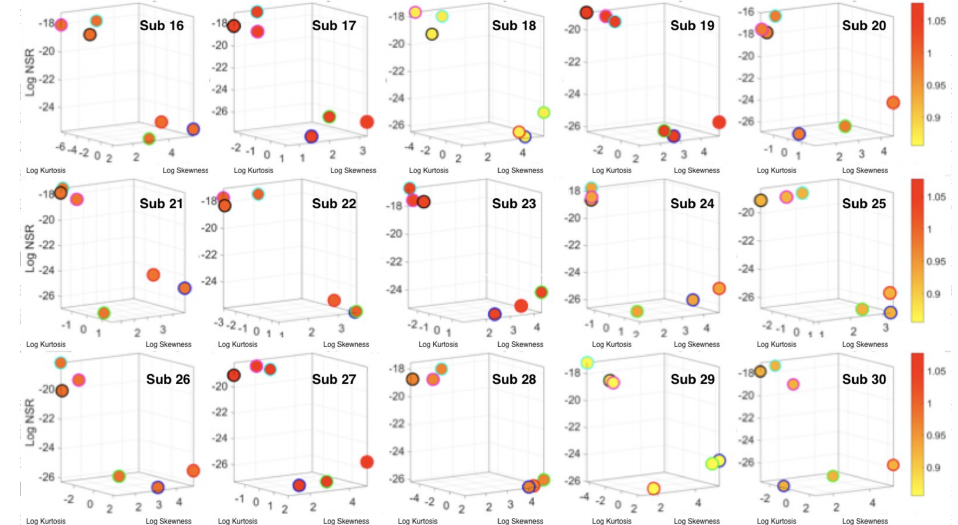
Figure 5. Individual results of the analyses of acceleration peak timings as micro-movements spike trains. Color represents median acceleration motion range across the cohort of 15/30 participants (the other 15 are in the Appendix B for better visualization). In each participant the timing stochastic signatures of standing, sitting and laying separate from those of walking, walking upstairs and walking downstairs.